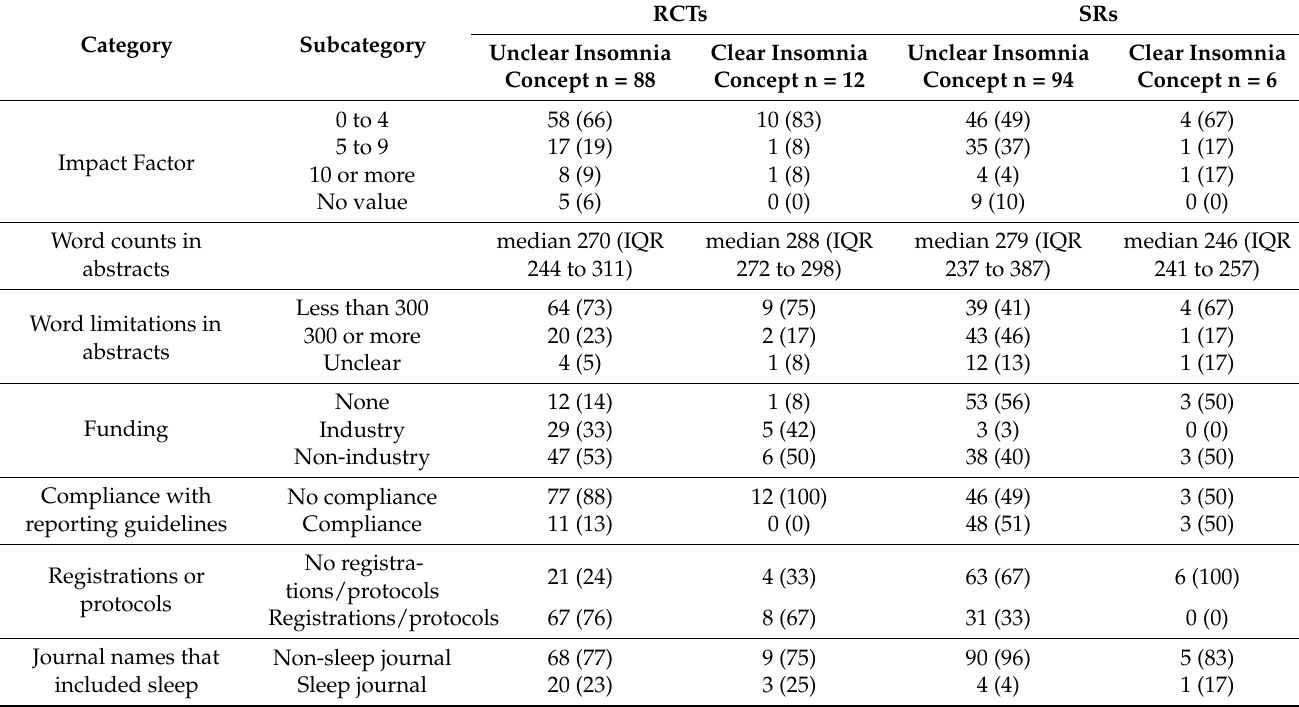
Table 2. Characteristics of RCT and SR abstracts in which the insomnia concept is unclear and